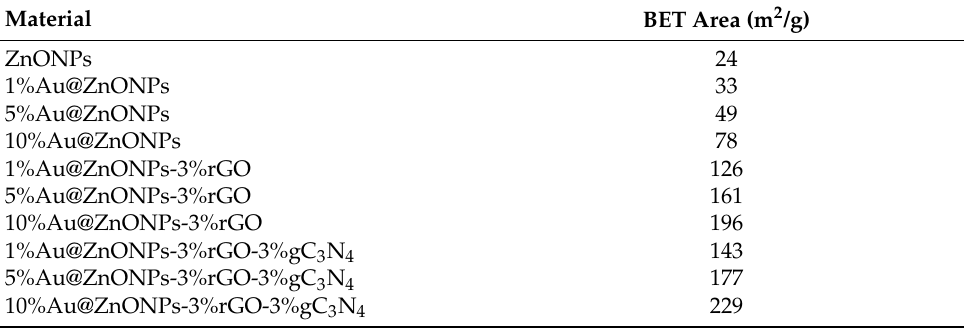
Table 1. BET surface area of the different as-synthesized